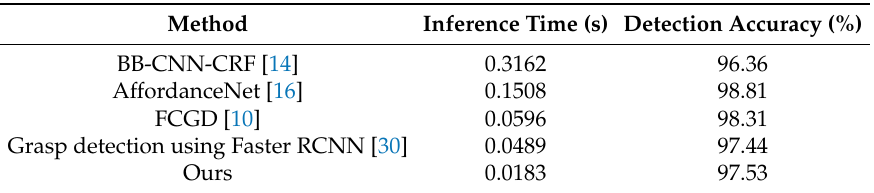
Table 6. Comparison of different solutions for parcel sorting